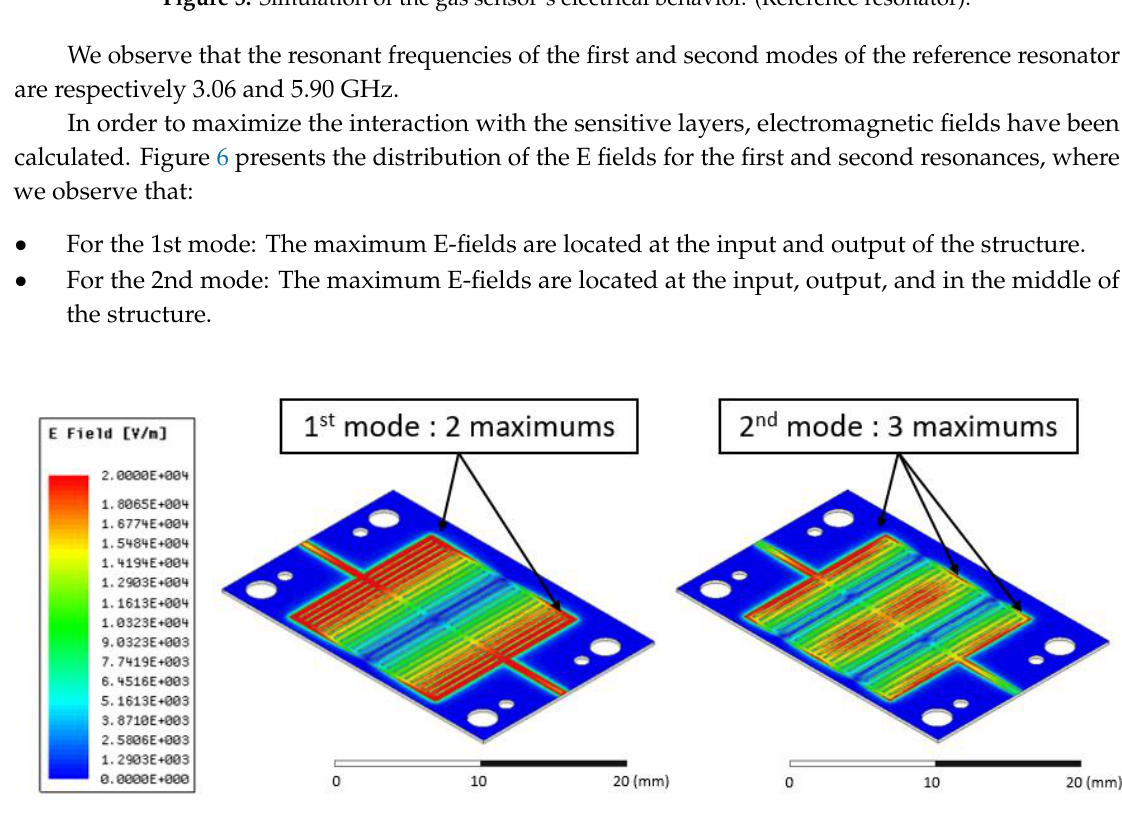
Figure 6. Magnitude of electrical fields in the structure.